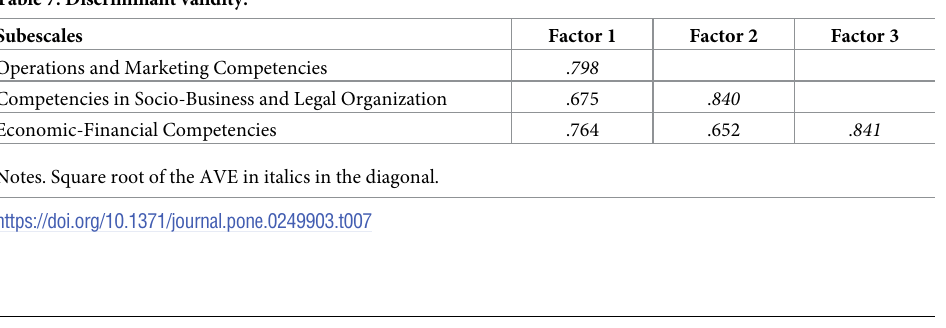
Table 7. Discriminant